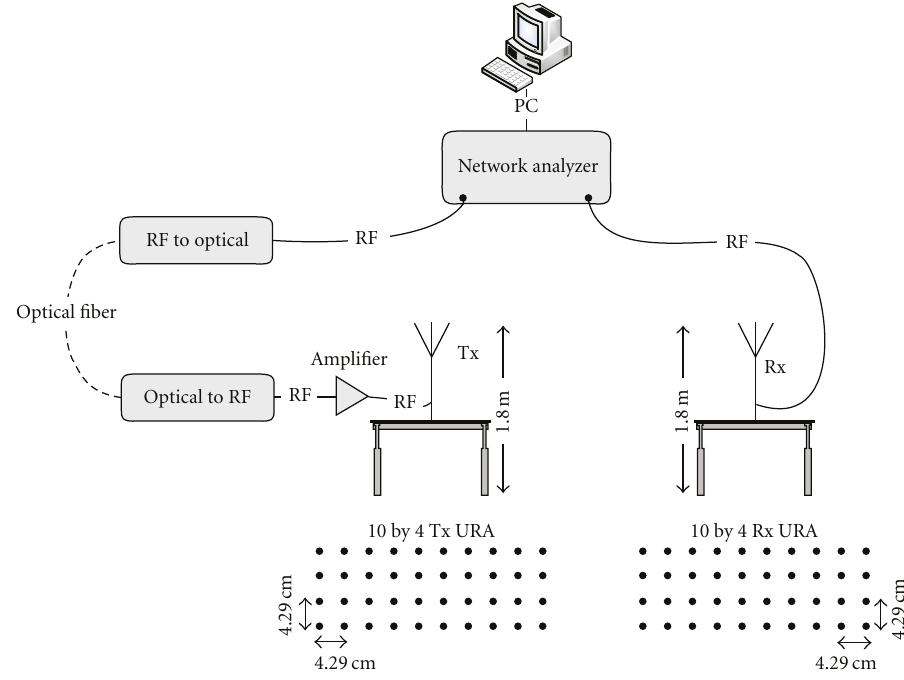
Figure 1: Measurement